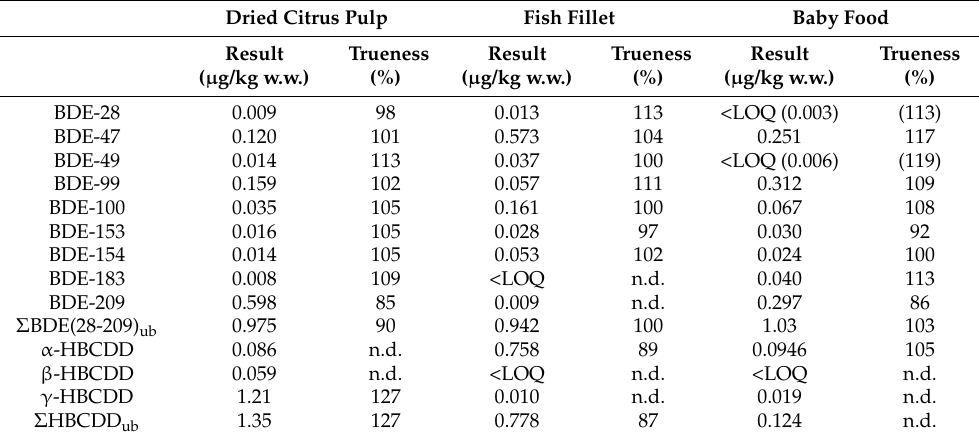
Table 4. Results of analysed PT samples and calculated trueness of the determinations.